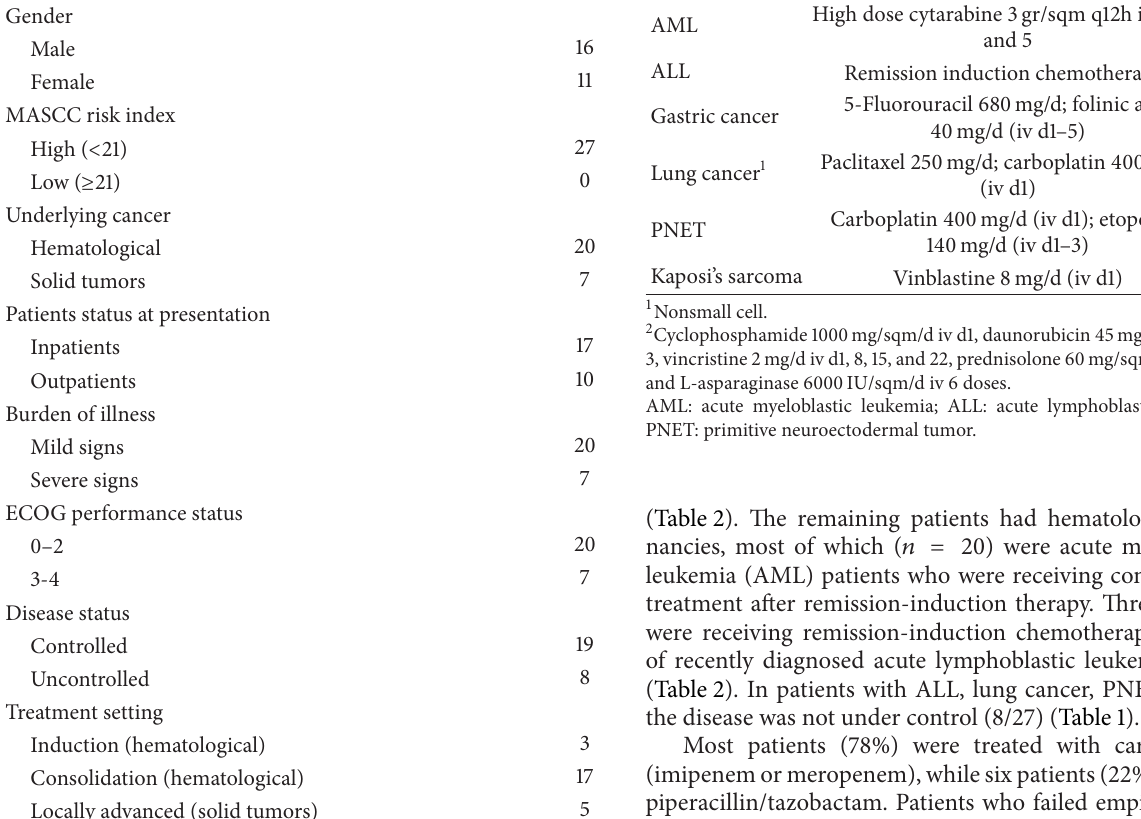
Table 1: Patient’s demographic, clinic, and laboratory results. Characteristics